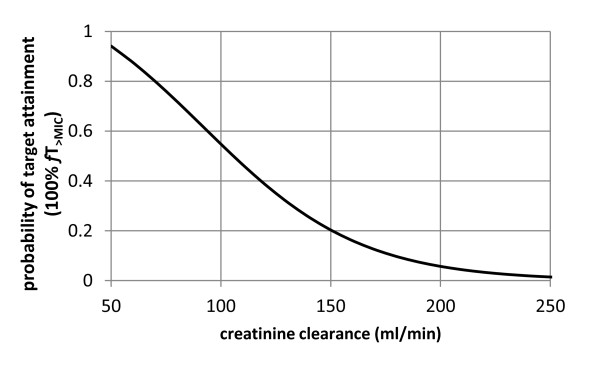
Predicted probability of 100% fT>MIC target attainment.